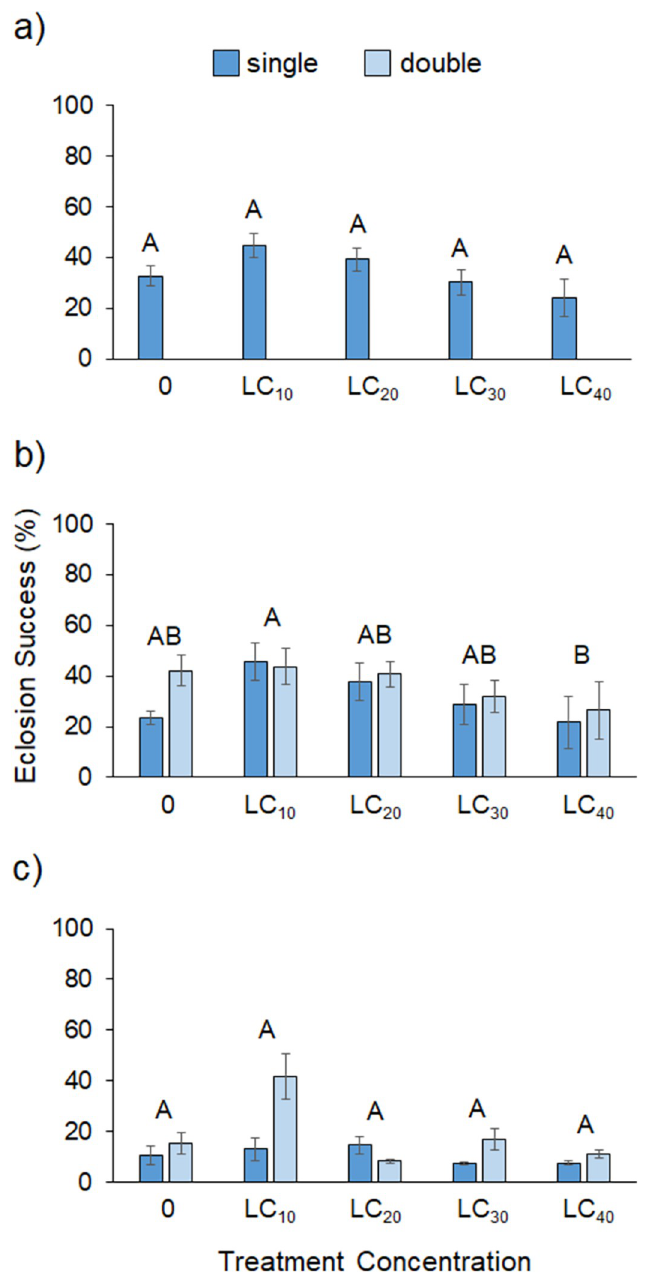
Fig 4. Eclosion success. Eclosion success of offspring across single- and double-exposures for (a) zeta-cypermethrin (N = 17–20), (b) spinetoram (N = 8–10), and (c) pyrethrin (N = 5–10). Different letters indicate significant post-hoc differences between treatments (Tukey’s Test, P �